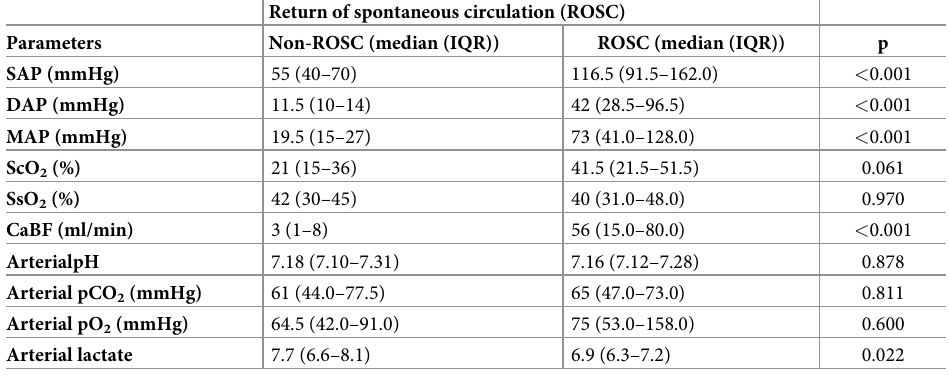
Table 3. Comparison of hemodynamic and respiratory parameters at 3 minutes of cardiopulmonary resuscitation in animals with and without